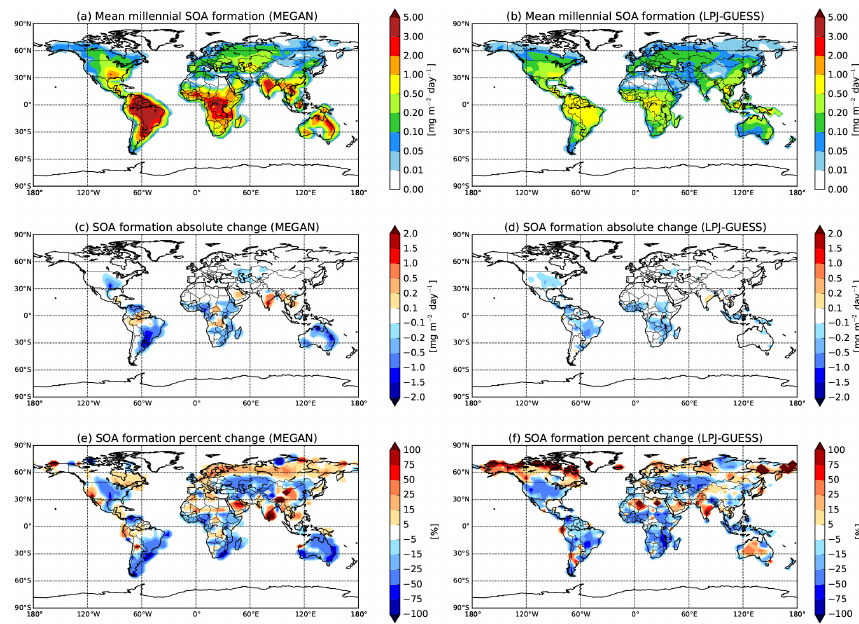
Figure 2. Mean millennial fixed-yield biogenic SOA formation from (a) MEGAN emissions and (b) LPJ-GUESS emissions between the periods 1000–2000 in mgm − 2 day − 1 . Absolute change in fixed-yield biogenic SOA formation from averaged (c) MEGAN BVOC emissions (monoterpenes, isoprene, and sesquiterpenes) and (d) LPJ-GUESS BVOC emissions (monoterpenes and isoprene) between 1000 and 2000 in mgm − 2 day − 1 . Relative change in fixed-yield biogenic SOA formation from averaged (e) MEGAN BVOC emissions (monoterpenes, isoprene, and sesquiterpenes) and (f) LPJ-GUESS BVOC emissions (monoterpenes and isoprene) between 1000 and 2000. An increase in SOA formation in (c) , (d) , (e) , and (f) is represented in red, and a decrease in SOA formation in